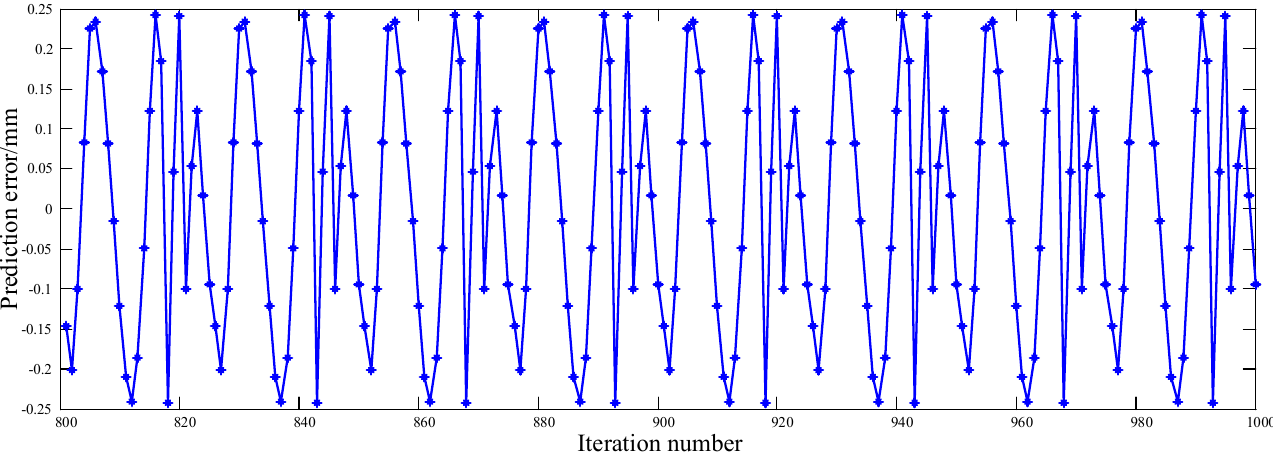
Figure 5. Prediction error of ICSO-SVM model of nonlinear system.